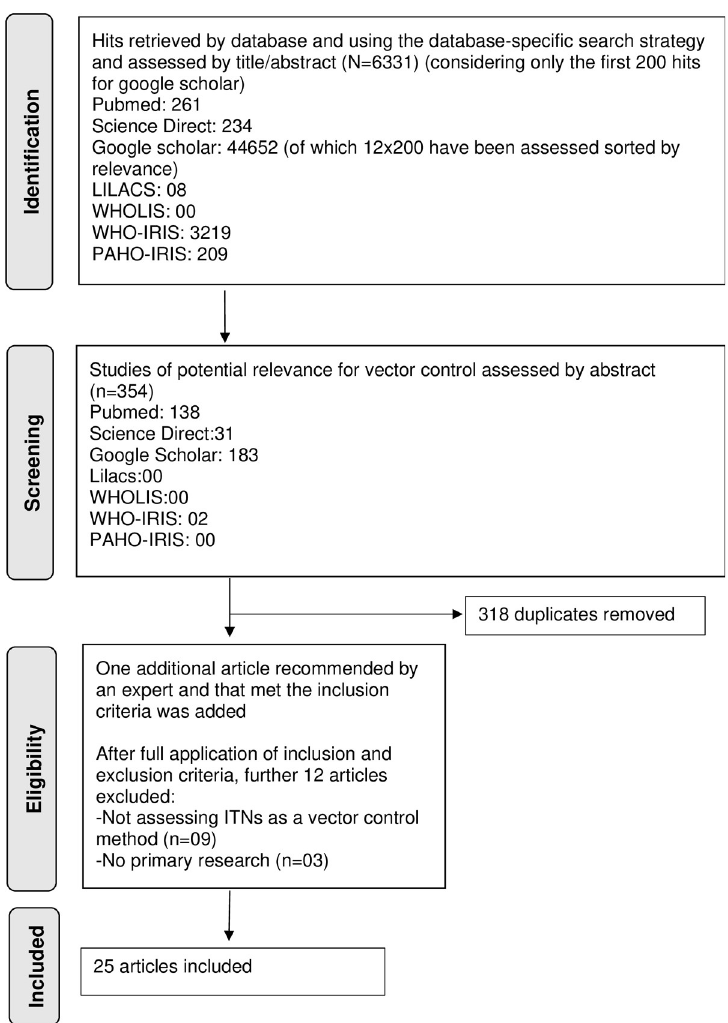
Fig 1. PRISMA flowchart for searches and inclusion of articles for Systematic Review on the use of insecticide treated nets for visceral leishmaniasis control.